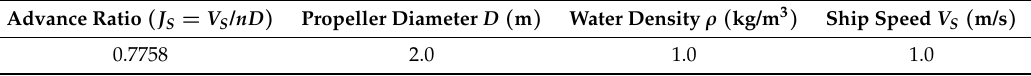
Table 2. Loading conditions used in RANS solver.